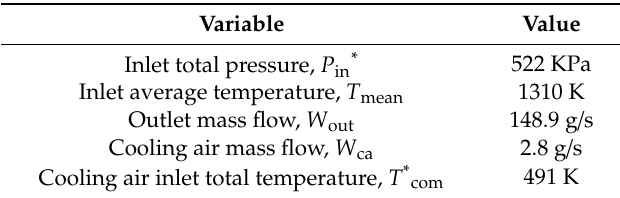
Table 4. Simulation conditions of the